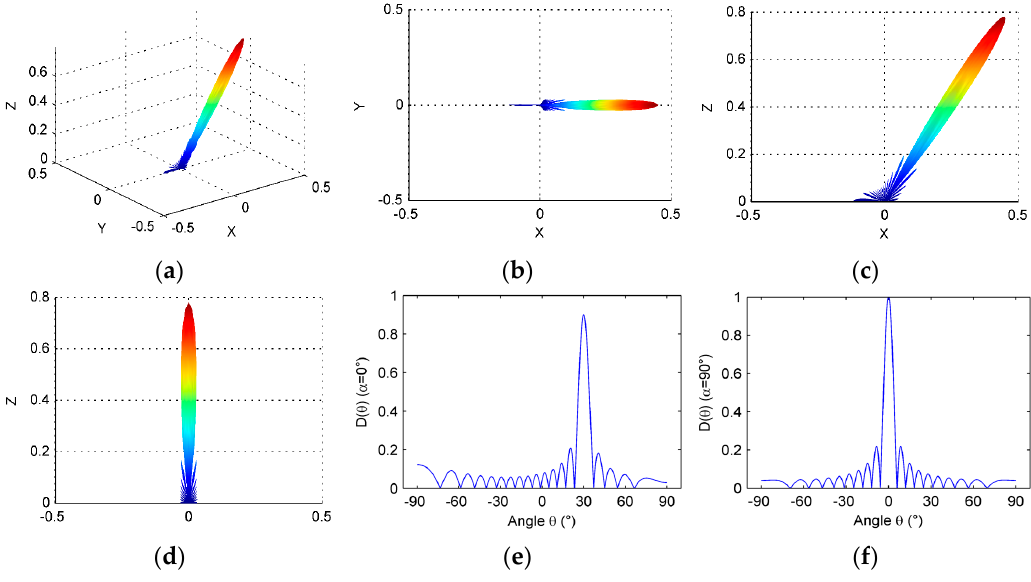
Figure 14. Directivity of linear phased array after optimizing parameters comprehensively: ( a ) three-dimensional directivity; ( b ) directivity pattern in x - y plane; ( c ) directivity pattern in x - z plane; ( d ) directivity pattern in y - z plane; ( e ) directivity pattern when α “ α 0 “ 0 ˝ ; and ( f ) directivity pattern when α “ α 0 “ 90 ˝